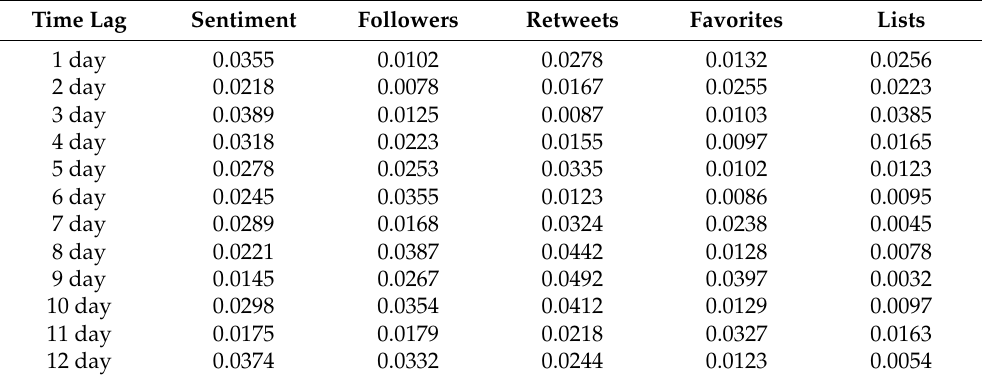
Table 9. Statistical significance ( p -values) of bivariate Granger causality correlation for Litecoin popularity based on tweet sentiment, followers, retweets, favorites, and lists. Time Lag Sentiment Followers